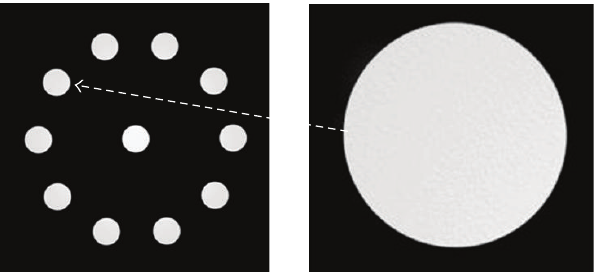
Figure12:ReconstructionimagesusingtheFBPformula(9)includ- ing a deflection angle of linear